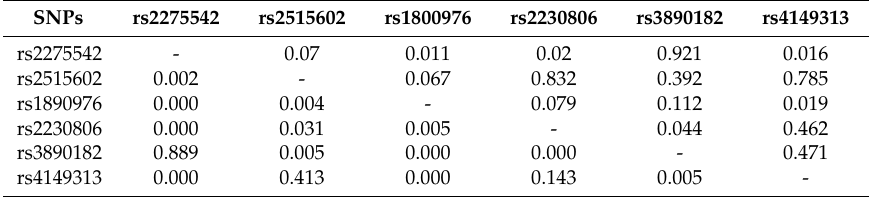
Table 5. Pairwise LD between six SNPs in ABCA1 in the normal weight and overweight/obesity. SNPs rs2275542